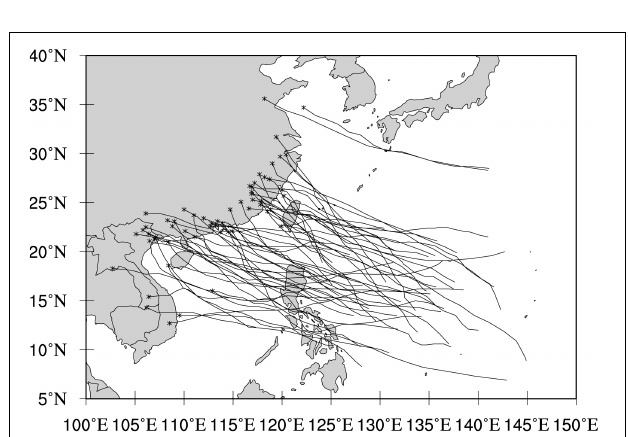
FIGURE 6 | The best tracks of the straight track cases of 2000–2019.